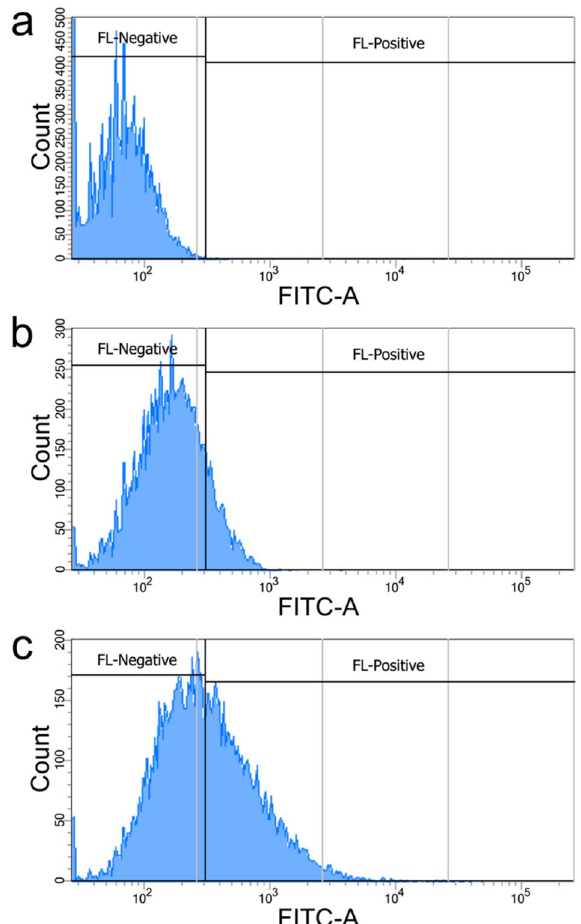
Figure 4. Effective cell-internalization of Pep-MD confirmed by FACS. ( a ) Distribution of fluorescence intensity in the control Hela cells in absence of any peptide. A threshold discriminating fluorescence (FL) negative and positive cells is defined at the tail of the distribution. ( b ) Intensity distribution of the cells incubated with TAT. Only 14% of the cells are FL-positive. ( c ) Intensity distribution with Pep-MD. More than 45% of the cells are